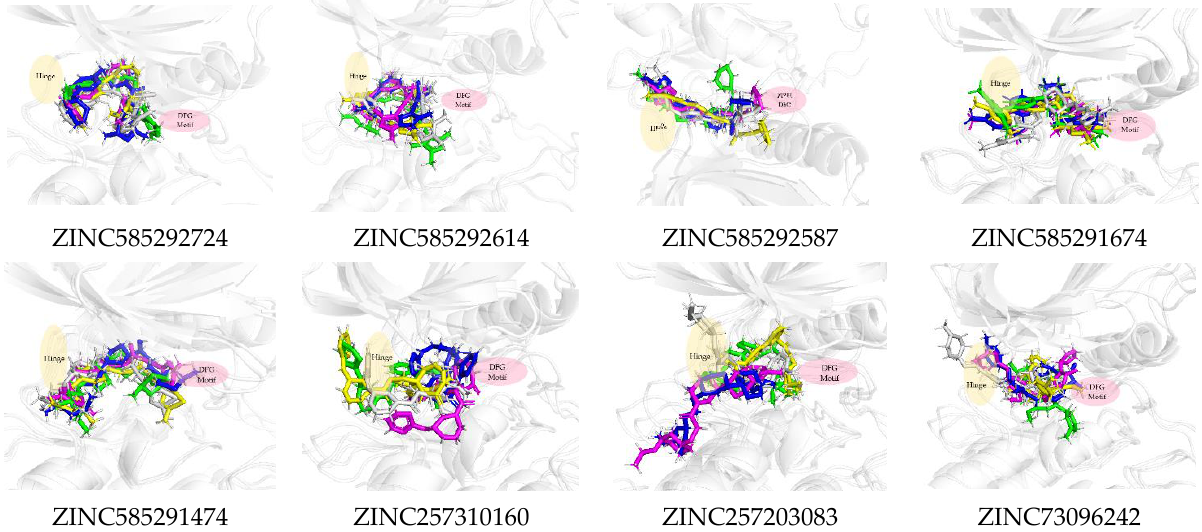
Figure 12. The superimposed ligand binding poses of hit compound at 0 ns (green), 100 ns (grey), and 200 ns (blue) in complexes with CDK6.